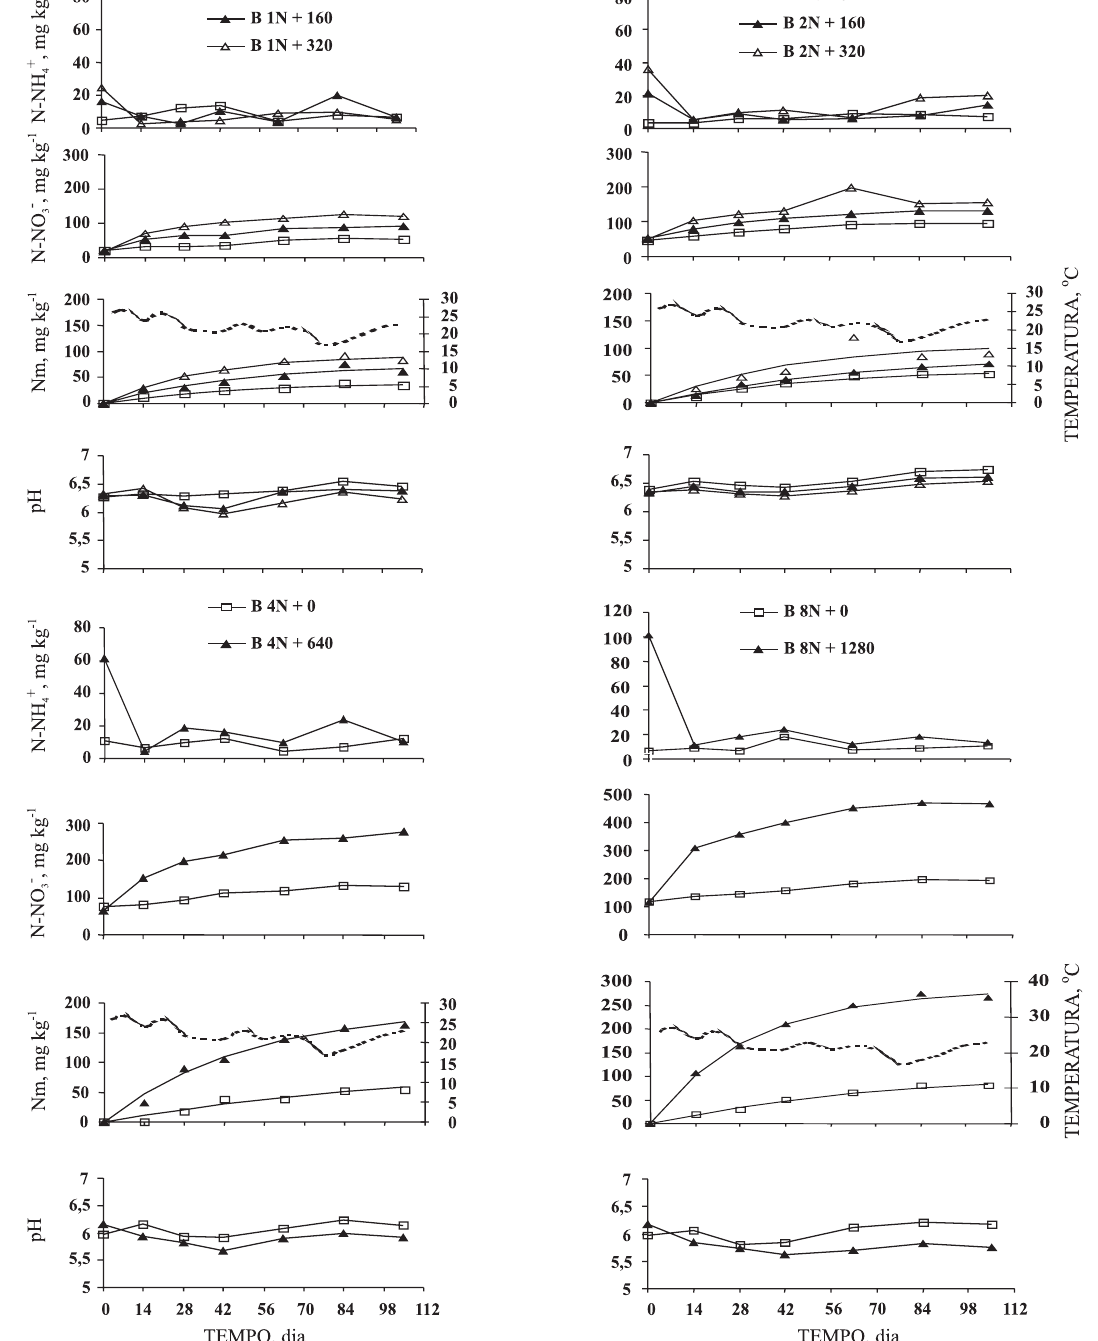
Figura 2. Efeito da quinta aplicação de doses de N orgânico (0, 160, 320, 640 ou 1.280 mg kg –1 ) via lodo de esgoto de Barueri, sobre os teores de N amoniacal e N-nítrico, N mineralizado (Nm) e pH, durante incubação de Latossolo pré-tratado com o resíduo. B 1N representa o Latossolo pré-tratado, em quatro cultivos sucessivos, com a dose de lodo calculada para adubação nitrogenada de milho; B 2N, B 4N e B 8N representam seus